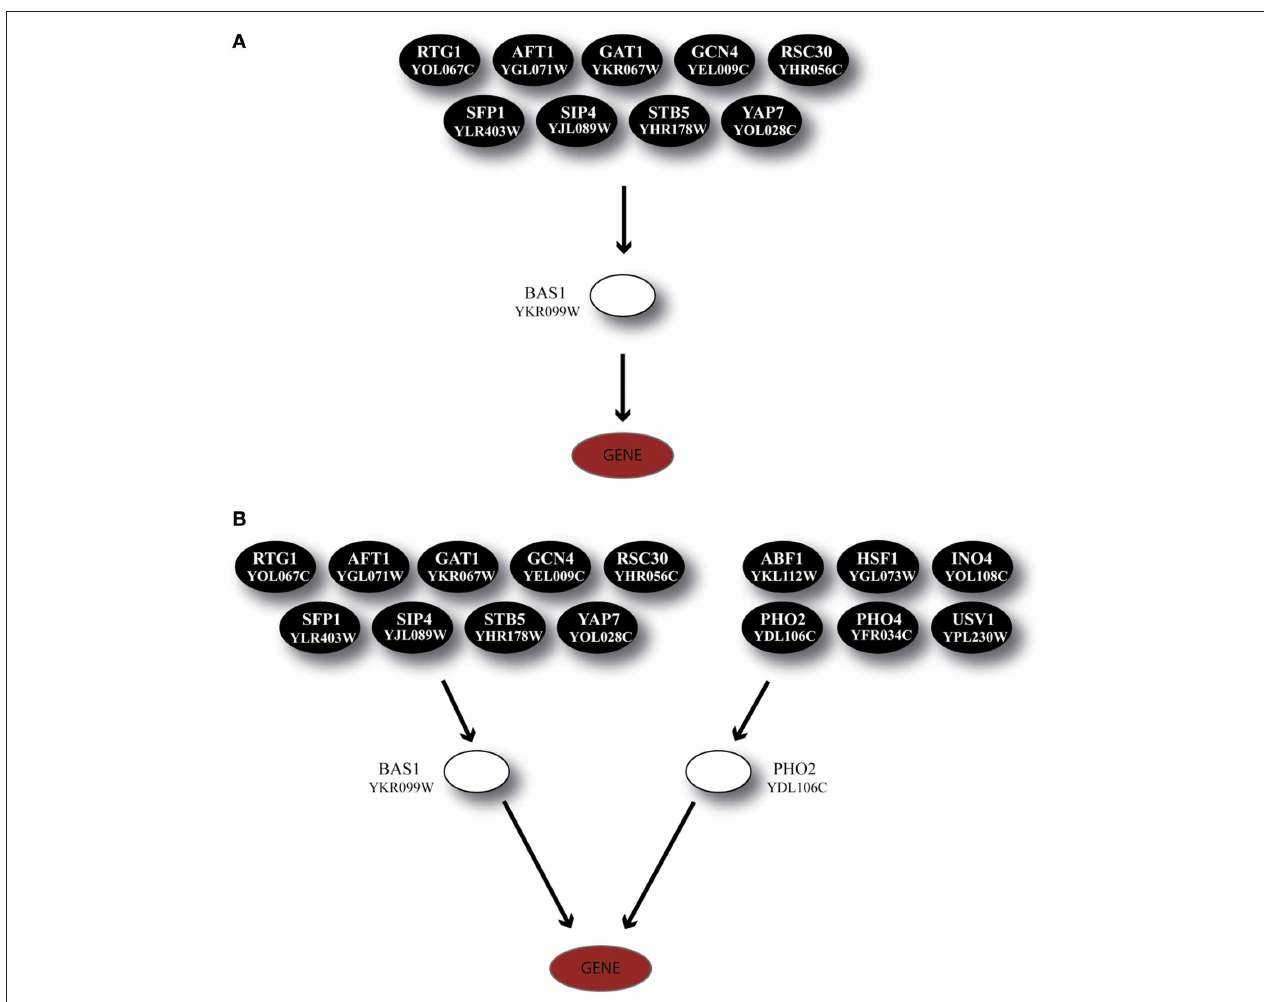
FIGURE 5 | Regulatory cascades containing the TF BAS1 as the GRAM-identified regulator. (A) Regulatory cascade where only BAS1 is considered as a regulator. (B) Regulatory cascade where BAS1 as well as